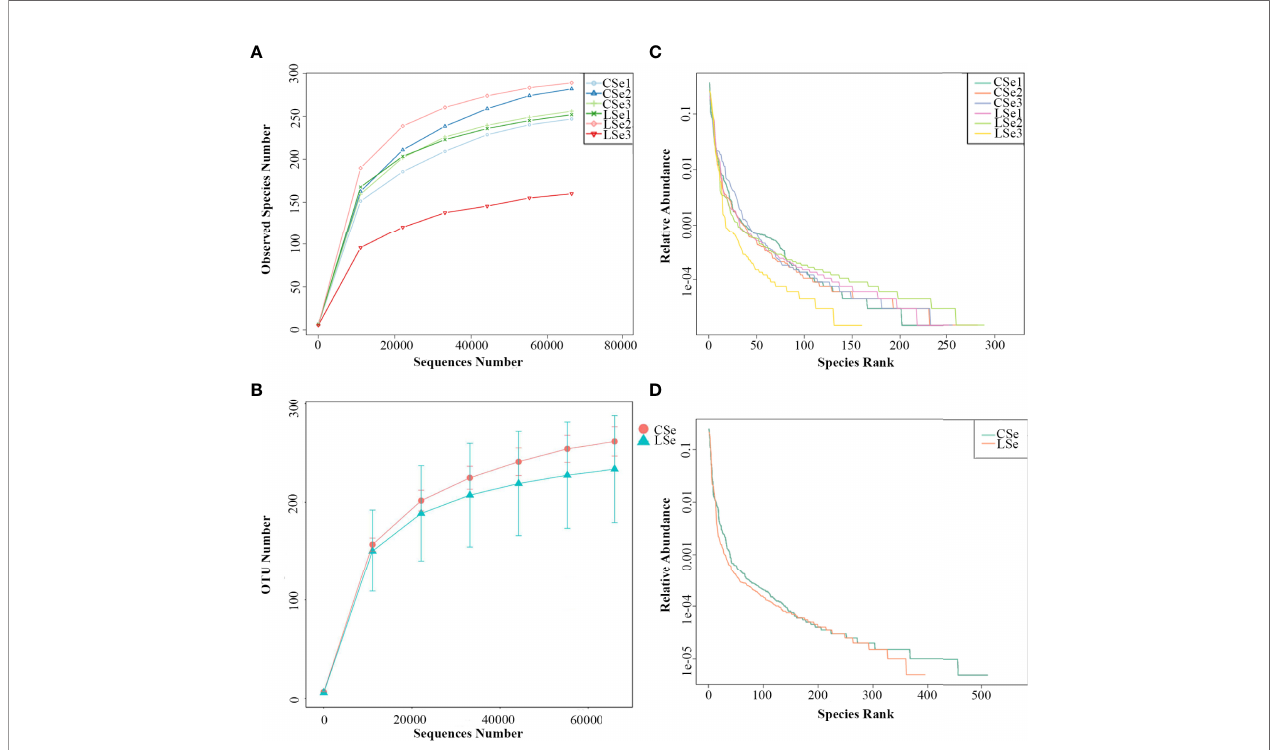
FIGURE 5 | Species dilution curve. (A) rarefaction Curve (Simple); (B) Rank Abundance (Simple);(C) rarefaction Curve (Group); (D) Rank Abundance